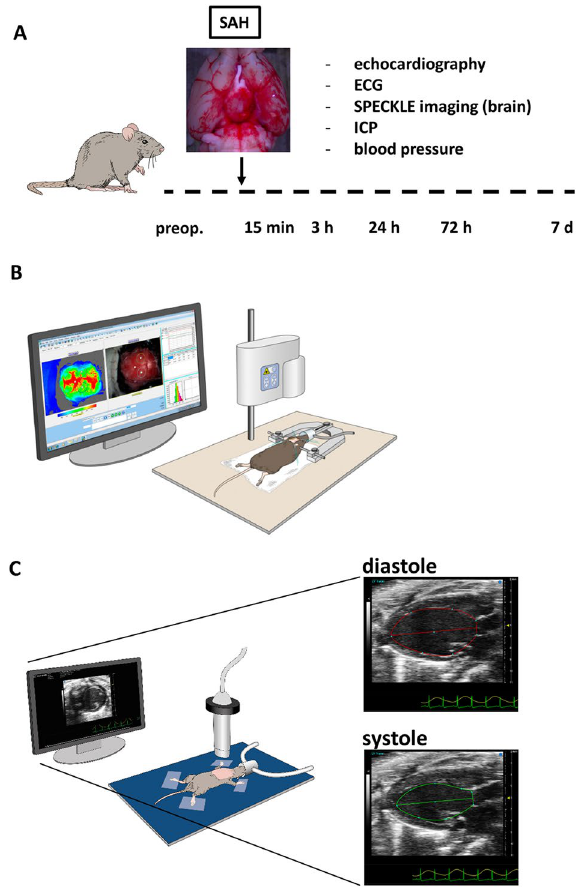
Figure 1. Study concept. ( A ) Study design. Mice were randomized to sham surgery and experimental subarachnoid hemorrhage (SAH) groups and subjected to serial measures of cerebral perfusion and cardiac function at the indicated times. ( B ) Schematic illustration of the SPECKLE imaging method for measuring cerebral cortical perfusion. ( C ) Illustration of high-frequency small animal transthoracic echocardiography for assessing cardiac output (CO), stroke volume, left ventricular ejection fraction (LVEF), and left ventricular end- diastolic volume